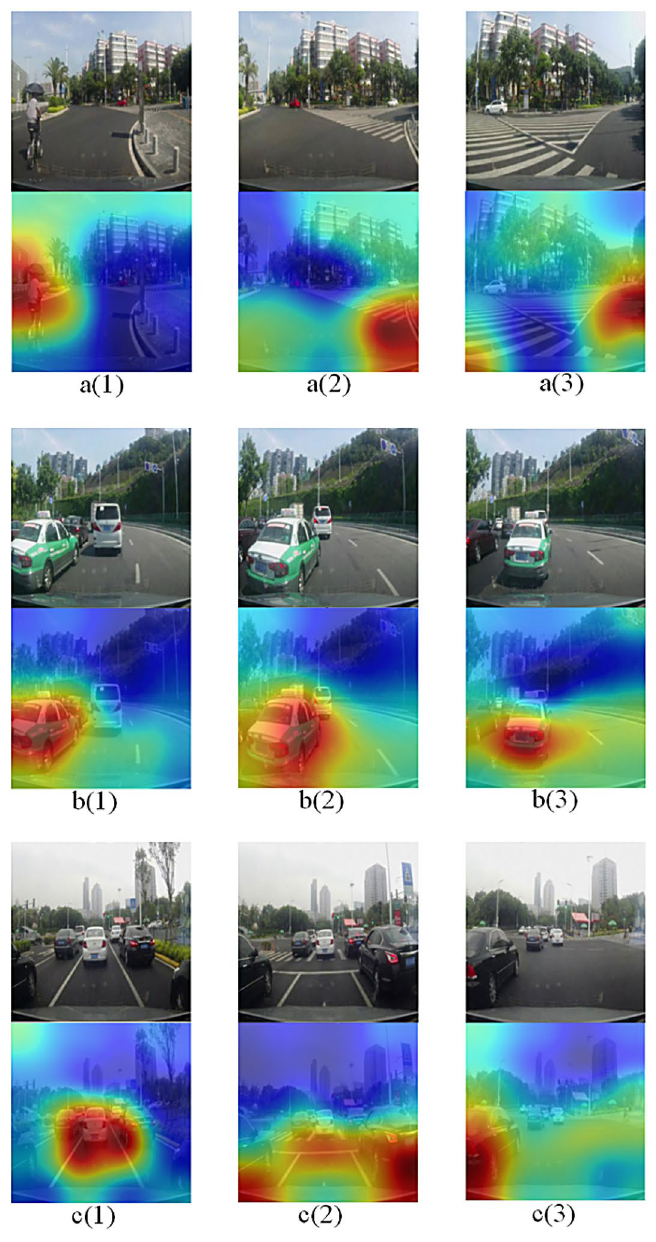
Figure 14. Imaging of the driver’s attention area in multiple scenarios, where a(1) – a(3) the current vehicle is turning; b(1) – b(3) the vehicle in front changes lanes; there are many surrounding vehicles in the scenes of c(1) – c(3)